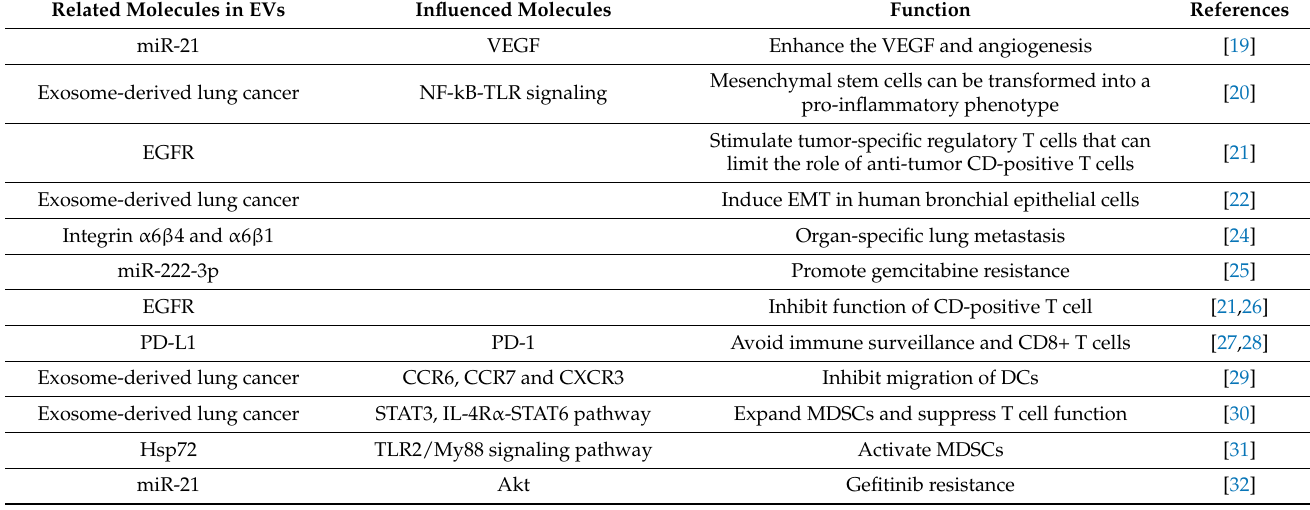
Table 1. Summary of the biological role of EVs in lung